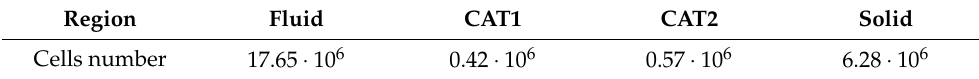
Table 4. Assessment of the emissions’ abatement at the cold start: computational domain details. Region